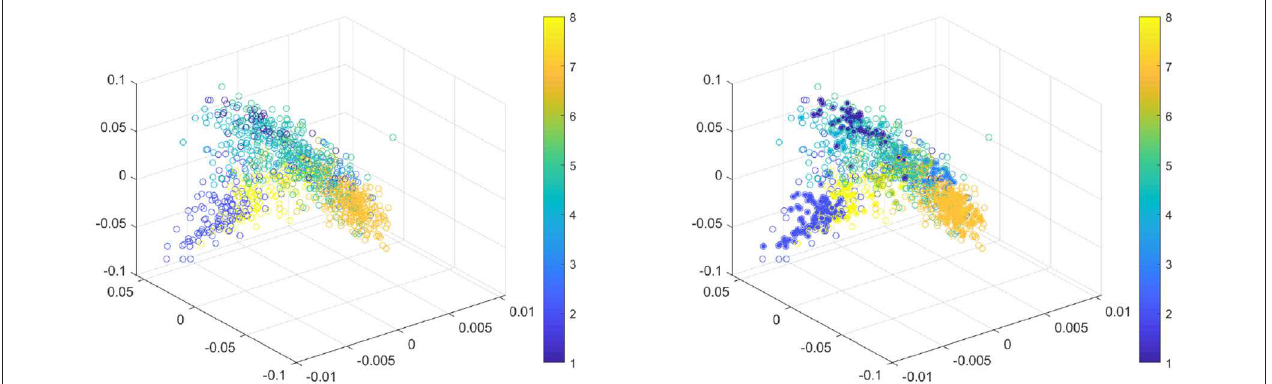
FIGURE 5 | (Left) Hierarchical topic embedding of documents. (Right) Embedding highlighted by grid points deemed significantly within one class.